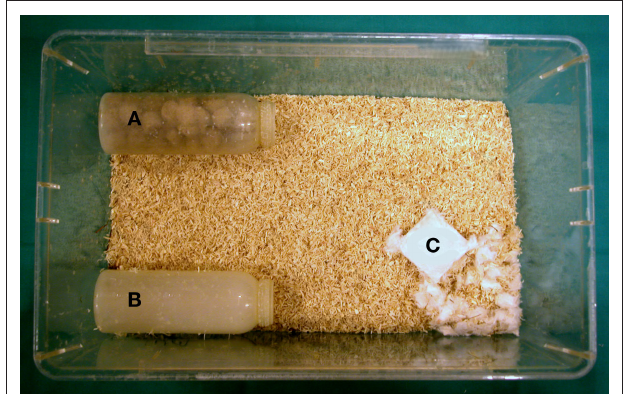
Figure 1 | experimental setup. Burrowing test apparatus (A) , shelter (B) , and nesting material (C) in home